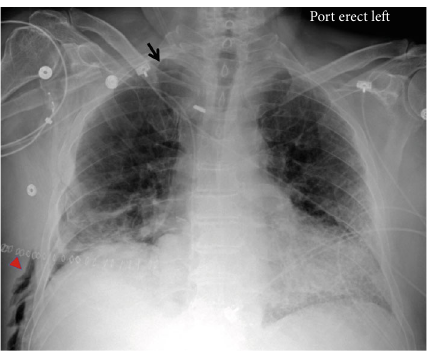
Figure 1: Chest X-ray showed right-sided subcutaneous emphysema (red caret) with a small right-sided pneumothorax (black